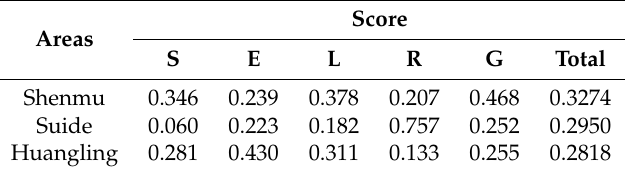
Table 4. Regional score of green development level medium.